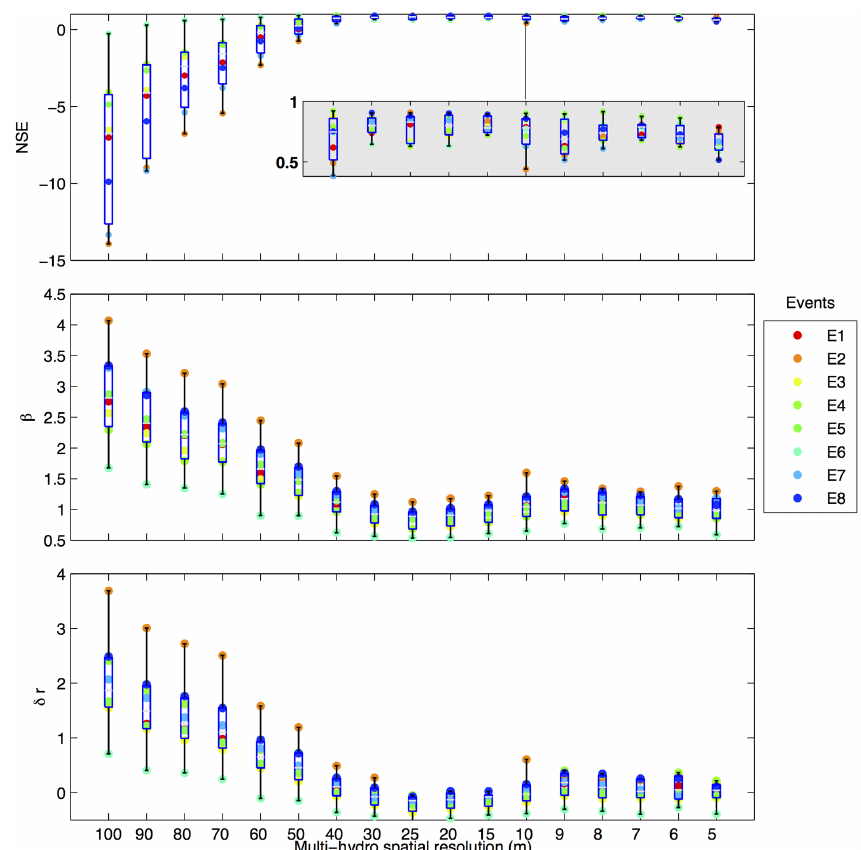
Figure 16. Performance indicators NSE, β and δr estimated from Multi-Hydro modelling output obtained at the 17 spatial scales with respect to observed